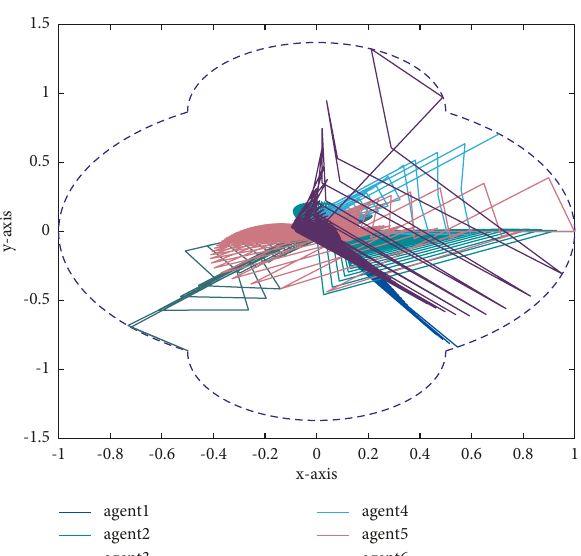
Figure 3: Nonconvex constraints of control